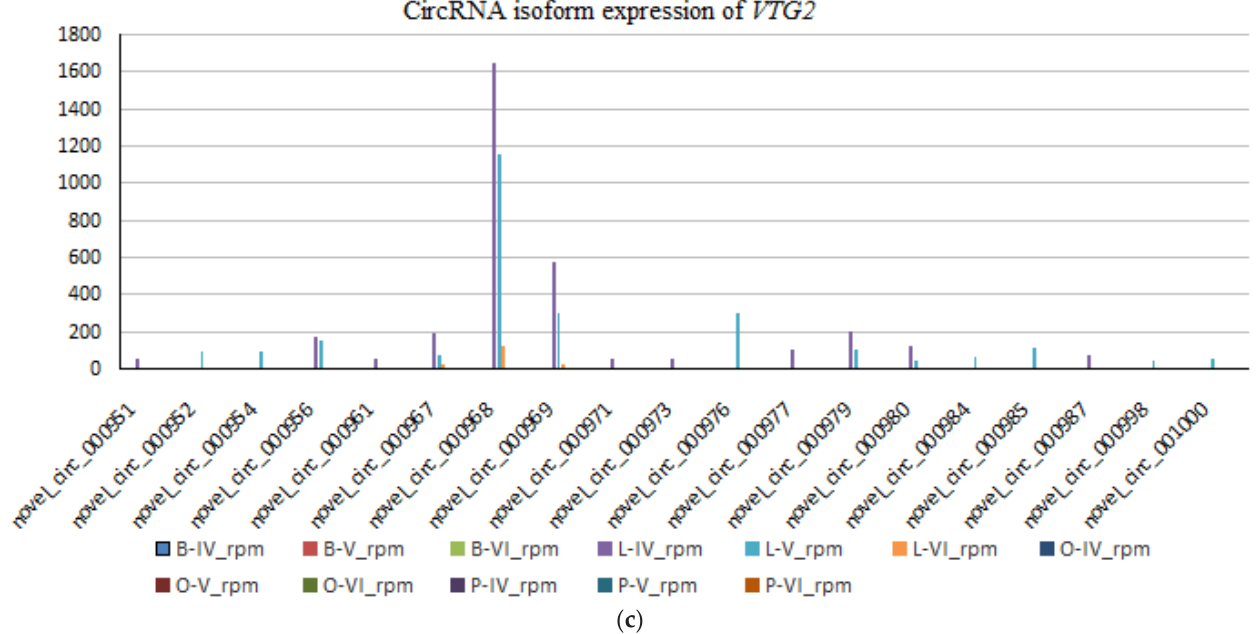
Figure 3. Characteristics of circRNAs in ovary (O), brain (B), pituitary (P) and liver (L) tissue of the ovarian stages IV, V and VI. ( a ) Clustered heat map showing abundances of the corresponding parental genes of the top 40 most differentially expressed circRNAs in the ovarian stages IV, V and VI in the ovary, brain, pituitary and liver. ( b ) Numbers of circRNAs produced by the same parental gene. ( c ) Example of circ-VTG2 , which showed 19 alternative circRNA isoforms.